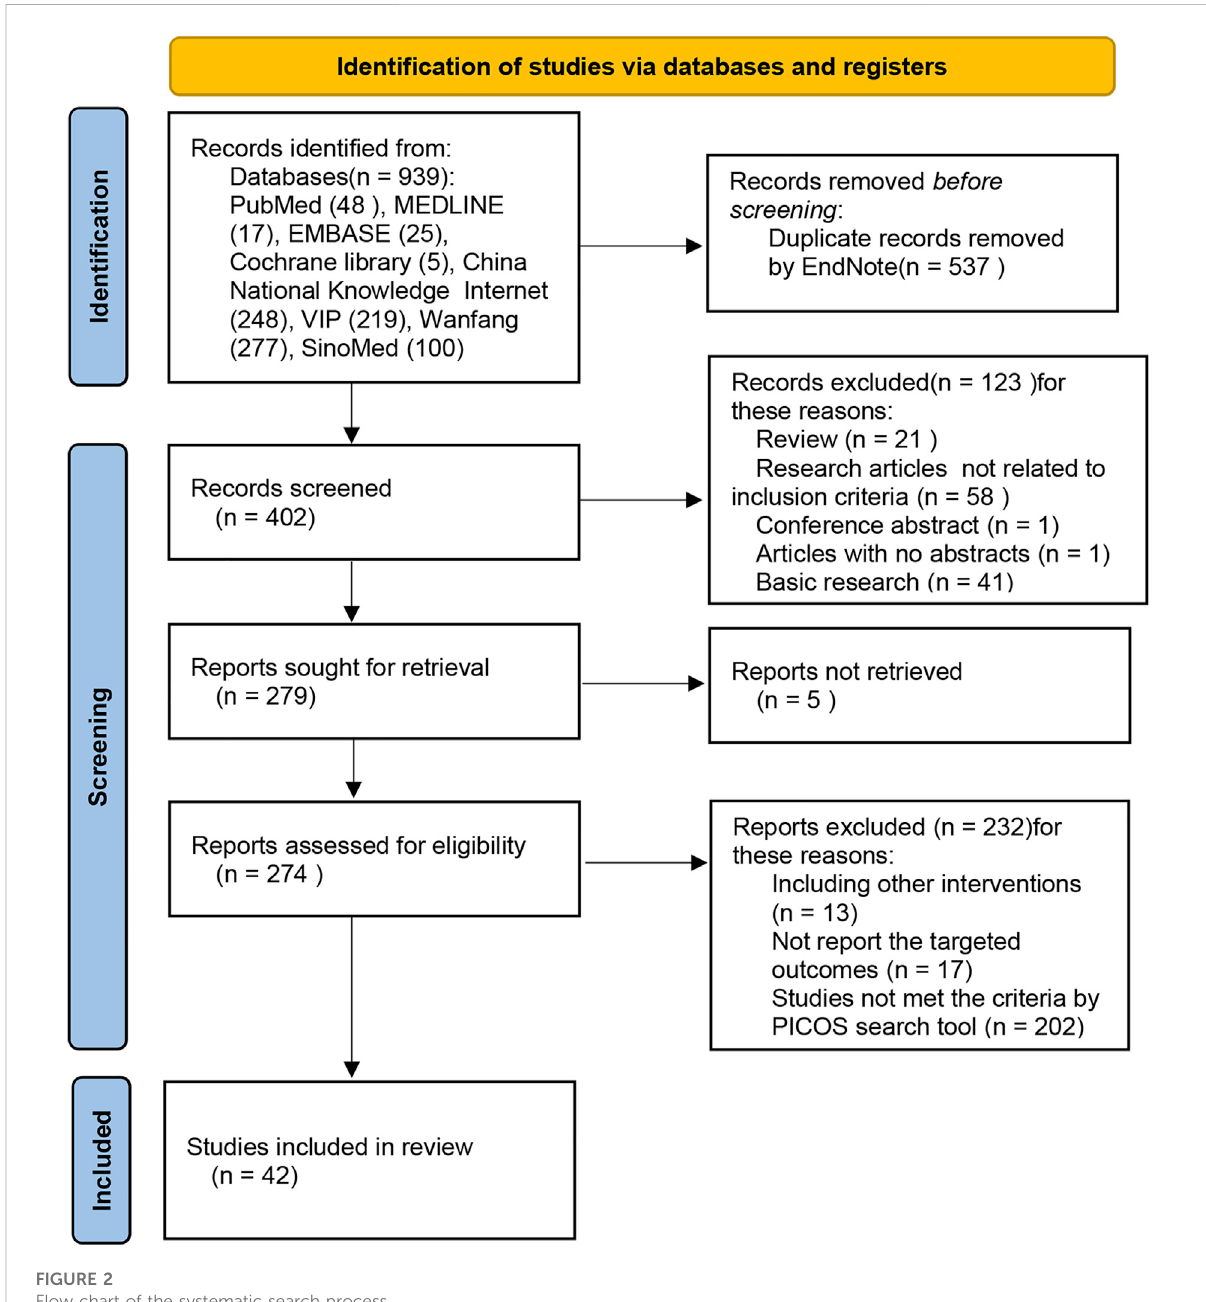
FIGURE 2 Flow chart of the systematic search